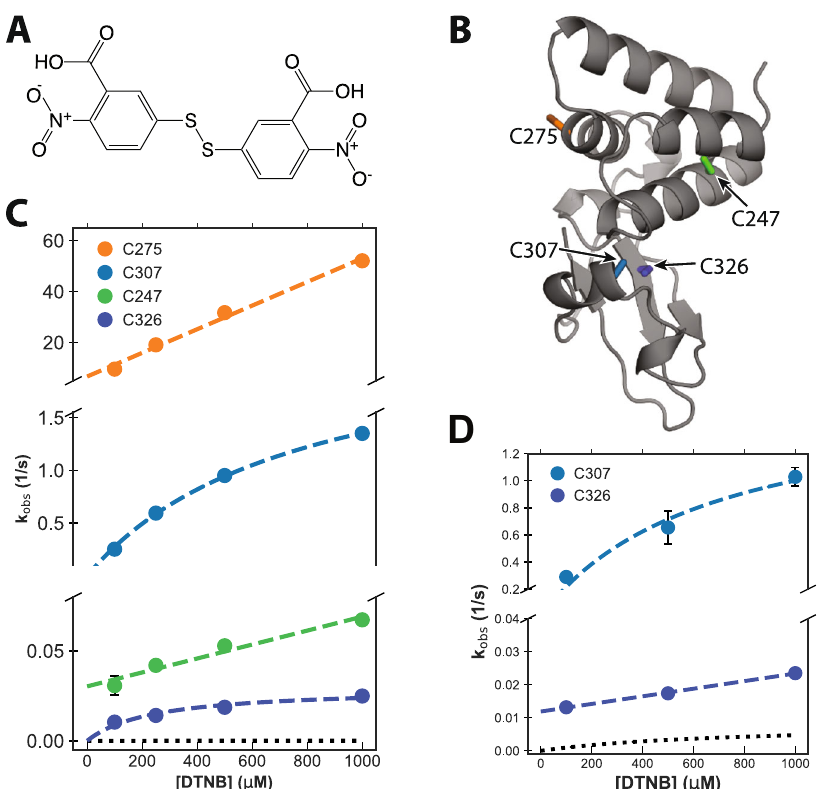
Fig. 4 Thiol labeling supports the existence of the predicted cryptic pocket. A Structure of the DTNB-labeling reagent. B Structure of VP35 ’ s IID highlighting the locations of the four native cysteines (sticks). C307 and C326 are both buried and point into the predicted cryptic pocket. C Observed labeling rates (circles) for WT VP35 at a range of DTNB concentrations. Fits to the Linderstrøm – Lang model are shown in dashed colored lines and the expected labeling rate from the unfolded state is shown as black dotted lines. The mean and standard deviation from three replicates is shown but error bars are generally smaller than the symbols. D Observed labeling rates (circles) for VP35 C247S/C275S. Fits to the Linderstrøm – Lang model are shown in dashed colored lines, and the expected labeling rate from the unfolded state is shown as black dotted lines. The mean and standard deviation from three replicates is shown but error bars are generally smaller than the symbols. Source data are provided as a Source Data fi